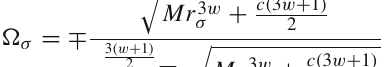
Fig. 2 The plots shows the time-like orbital frequency (cid:9) σ to the radial coordinate r σ of corotating orbits (left panel) and counterrotating orbits (lower panel) for different values of w . We use units M = 1 , a = 0 . 9 and c = 2